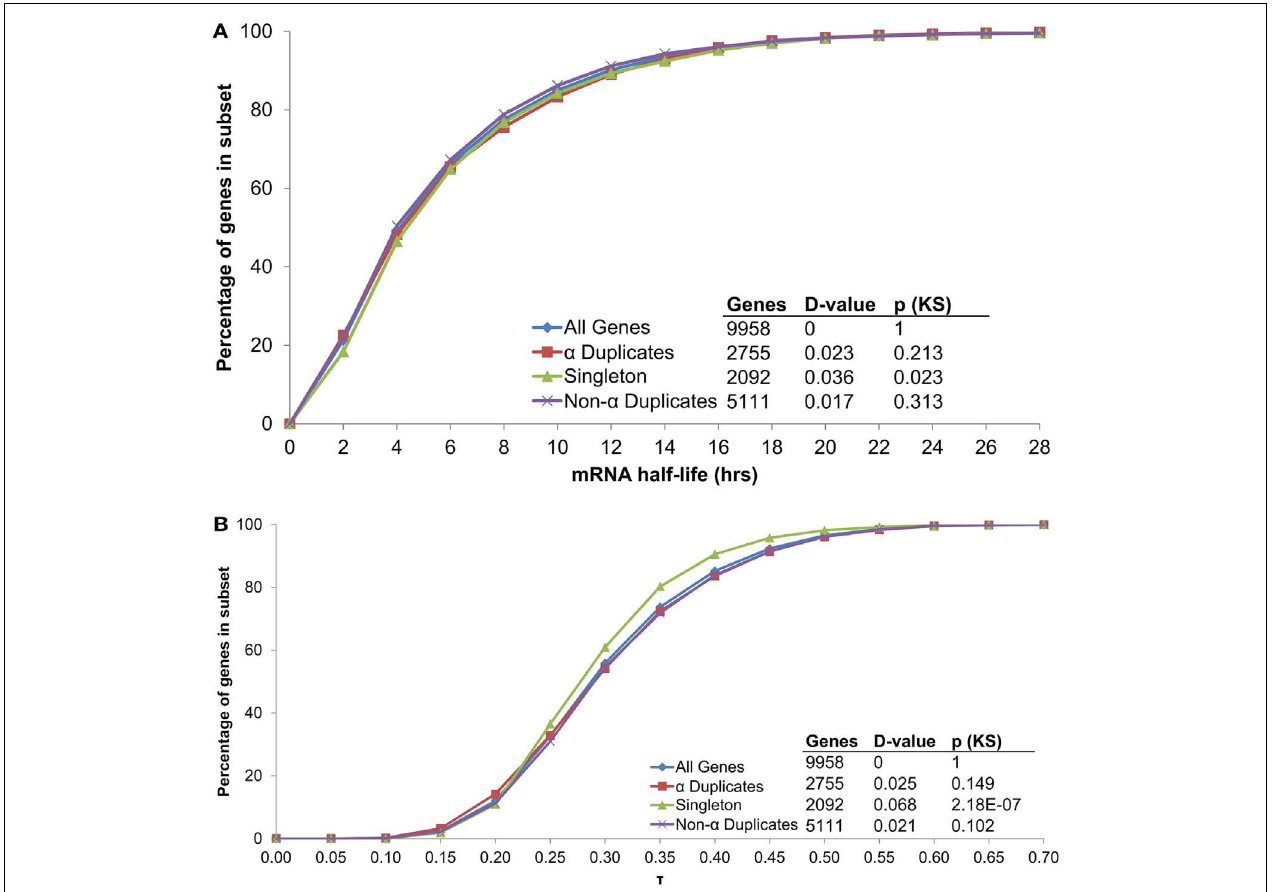
FIGURE 7 |The distribution of (A) mRNA half-lives and (B) τ across genes grouped by duplication status